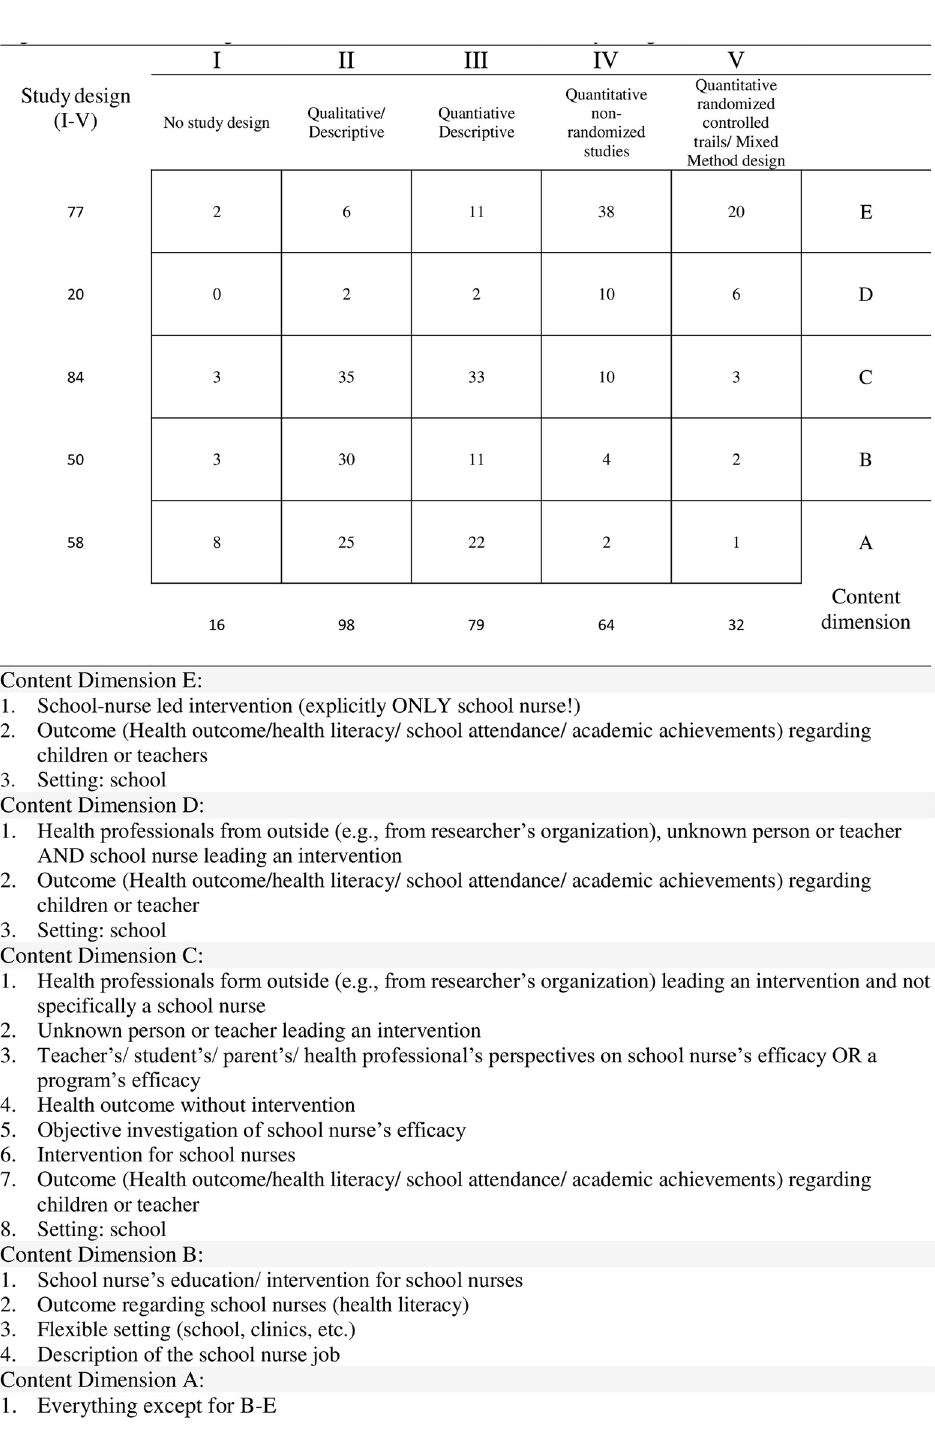
Fig 6. Matrix for categorization of content dimension and study design (with